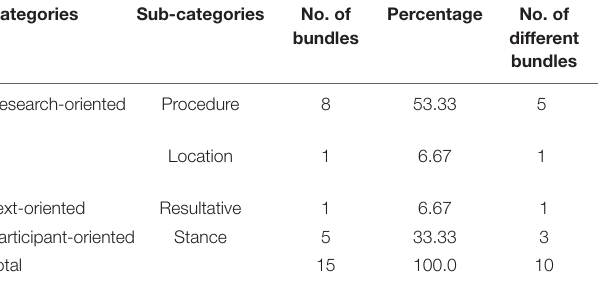
TABLE 1 | Functional categories in the abstract section of